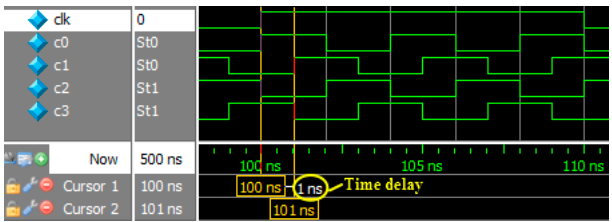
Figure 9. Simulation of PLL multiplication and phase shifting.